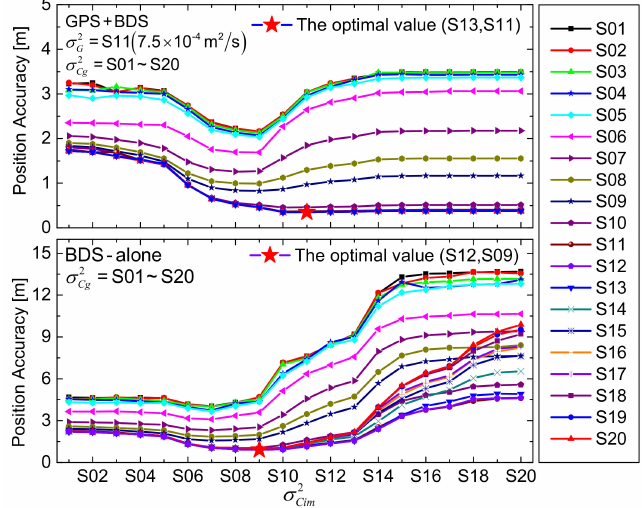
Figure 3. The real-time orbit accuracies for di ff erent σ 2 in the GPS + BDS and BDS-alone